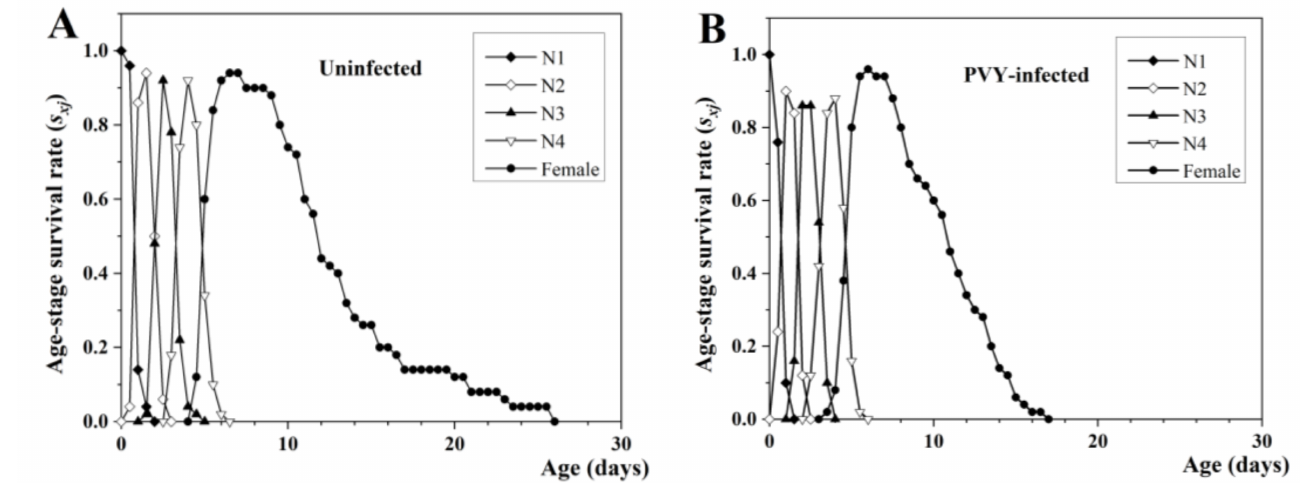
Figure 1. Age-stage-specific survival rate ( s xj ) of M. persicae on uninfected ( A ) and PVY-infected ( B ) tobacco plants. N1-N4 represent the 1–4 instar nymphs of M. persicae ,